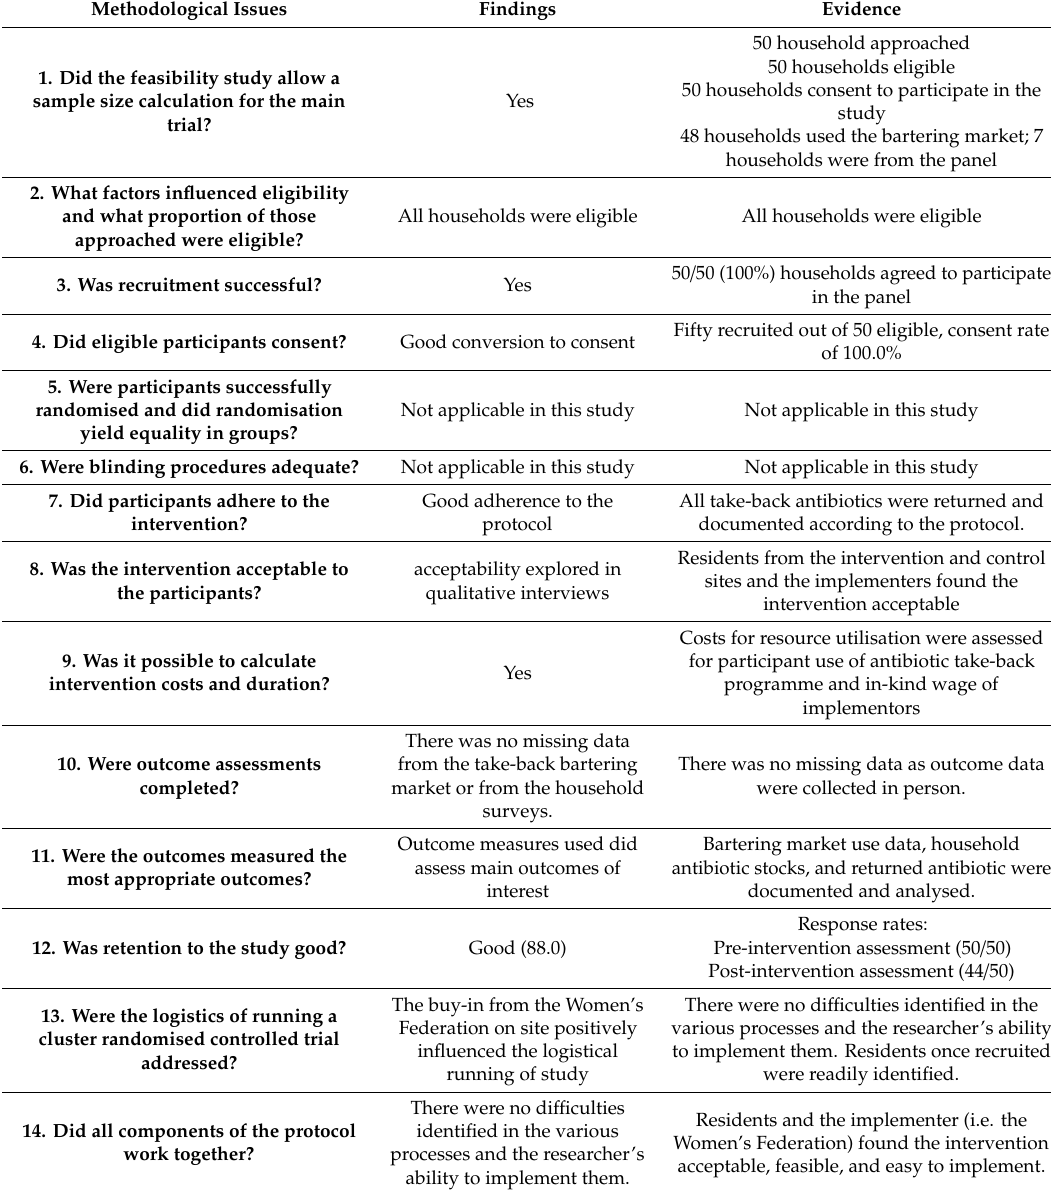
Table 4. Summary of the findings against 14 methodological issues for feasibility